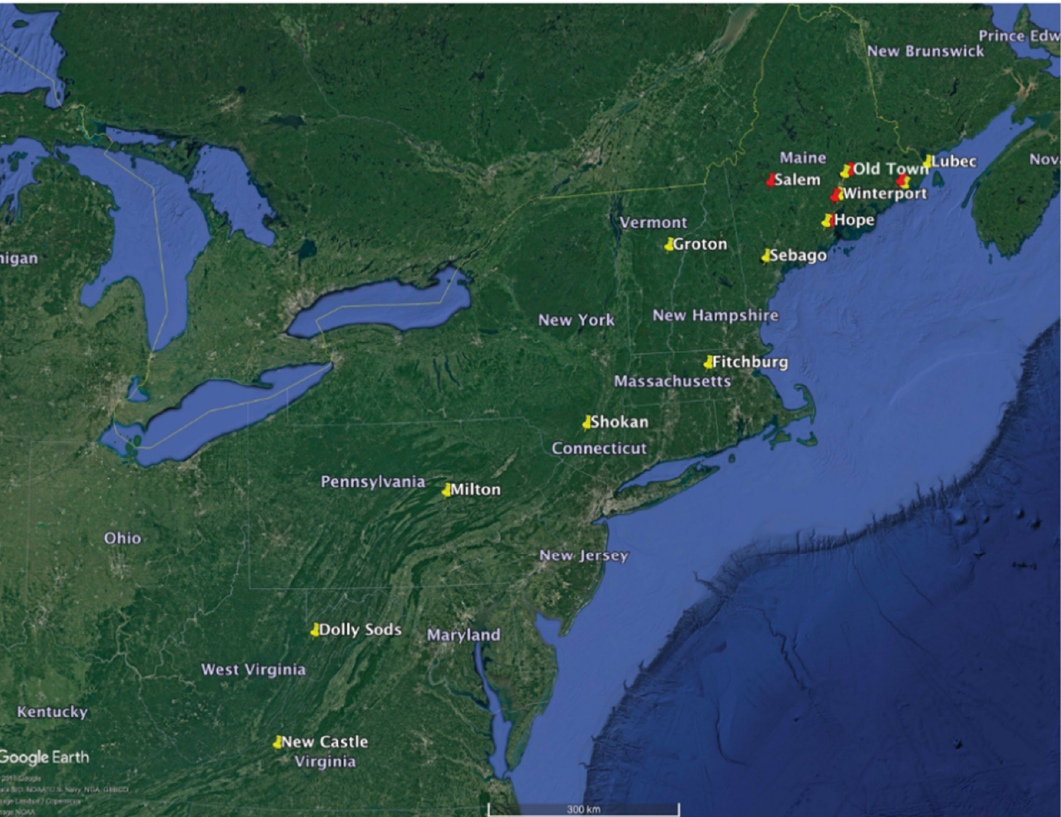
Figure 1. Sampled lowbush blueberry populations. Populations were collected along a 1600 km transect and represented a range of cold hardiness zones and a general north to south gradient which includes a large portion of the native growing range in the eastern United States (Gleason and Cronquist, 1991). Populations in Maine include plants commercially managed (red pins) for fruit production (Jonesboro, Old Town, Winterport, Hope, Salem) and plants from non-managed (yellow pins) natural forested landscape sites (Lubec, Jonesboro, Old Town, Winterport, Hope, Sebago). All locations outside of Maine were sampled from a forested landscape with no known history of commercial management.